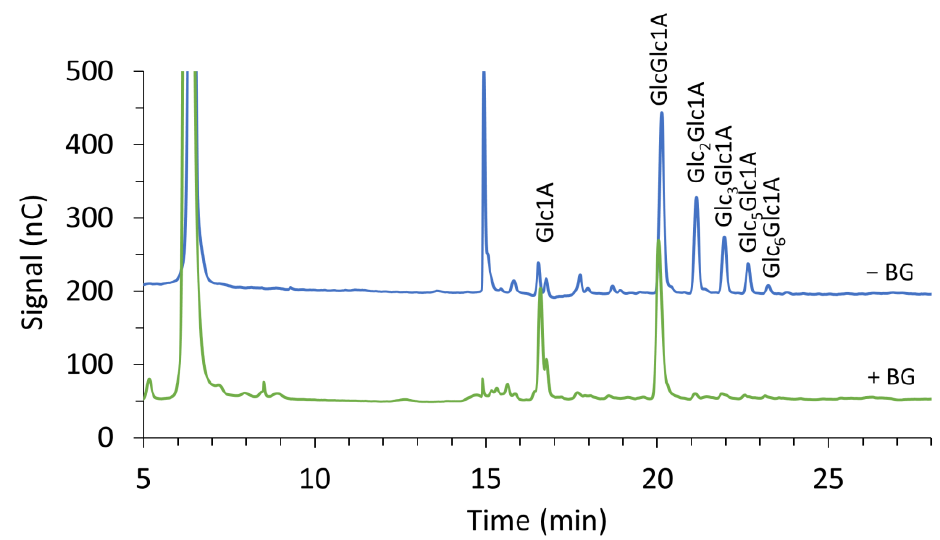
Figure 5. Products released from cellulose by Taus LPMO9B [47] before (blue line) and after (green line) treatment with BG; 1 µM Taus LPMO9B was incubated with 0.1% ( w / v ) PASC and 1 mM ascorbic acid in a 50 mM sodium acetate buffer pH 5 at 45 °C for 16 h. Reaction mixtures were centrifuged and filtered before the treatment of soluble products with 1 unit of BG from almonds (Sigma, St Louis, MO, USA) at 37 °C for 16 h in a 50 mM sodium acetate buffer pH 5. Glc1A, gluconic acid; GlcGlc1A, cellobionic acid; Glc2 Glc1A, cellotrionic acid; Glc3Glc1A, cellotetraonic acid; Glc5Glc1A, cellohexaoinic acid; Glc6Glc1A, celloeptaonic acid.